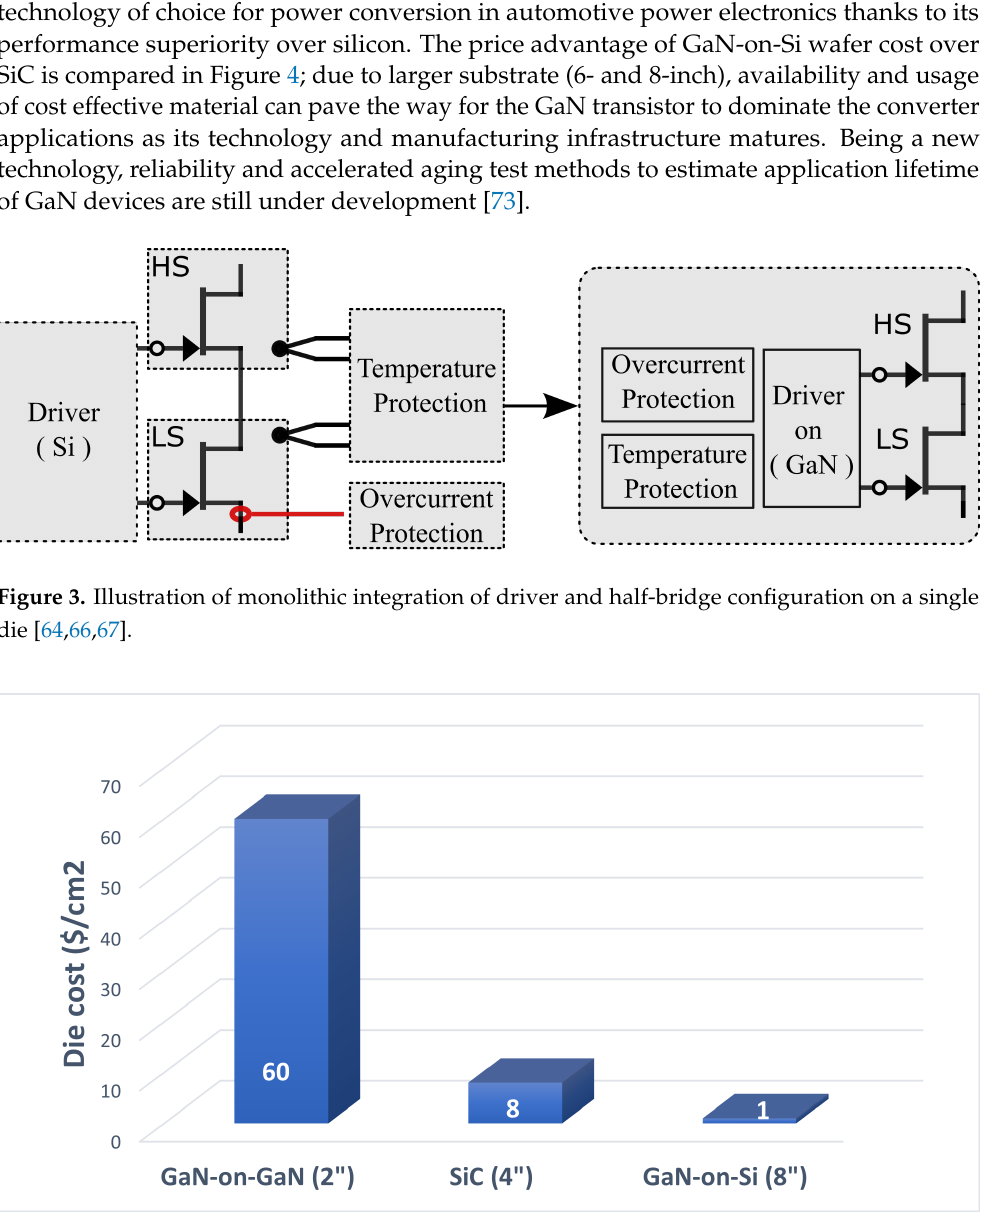
Figure 4. Comparison of wafer cost of GaN-on-GaN and GaN-on-Si technology with SiC wafer cost